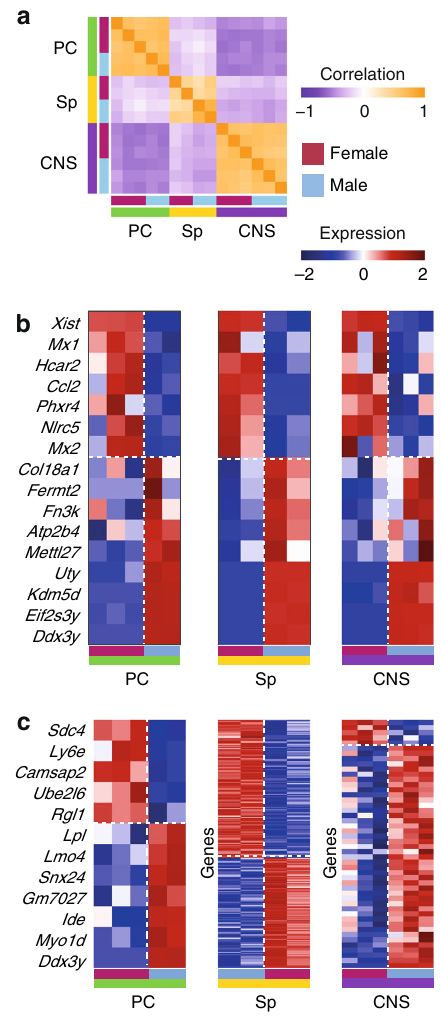
Fig. 6 Sexual dimorphism in macrophages across tissues. a Pearson correlation matrix of MFs from the peritoneal cavity (PC-MF, green), spleen (Sp-MF, yellow), and microglia (labeled CNS, purple), based on 10,264 genes expressed above the noise threshold, sorted by cell type and sex. b Heatmap of the expression values of genes that are signi fi cantly contributing (two-way ANOVA, pFDR < 0.2, female – male fold change >log 2 (1.5) in all three tissues) to sex effect across tissues (16 genes). c Heatmap of the expression values of genes that are signi fi cantly contributing to the sex – tissue interaction effect in speci fi c tissue (two-way ANOVA pFDR < 0.2, male – female tissue-speci fi c fold change >log 2 (1.5)): left PC-MF, middle Sp-MF, 127 female and 101 male speci fi c genes; right microglia (labeled CNS), 5 female and 43 male speci fi c genes. In b , c , dotted horizontal white lines separate female from male upregulated genes. Dotted vertical white lines separate female and male samples. Values were normalized per tissue. Source data for a – c are provided